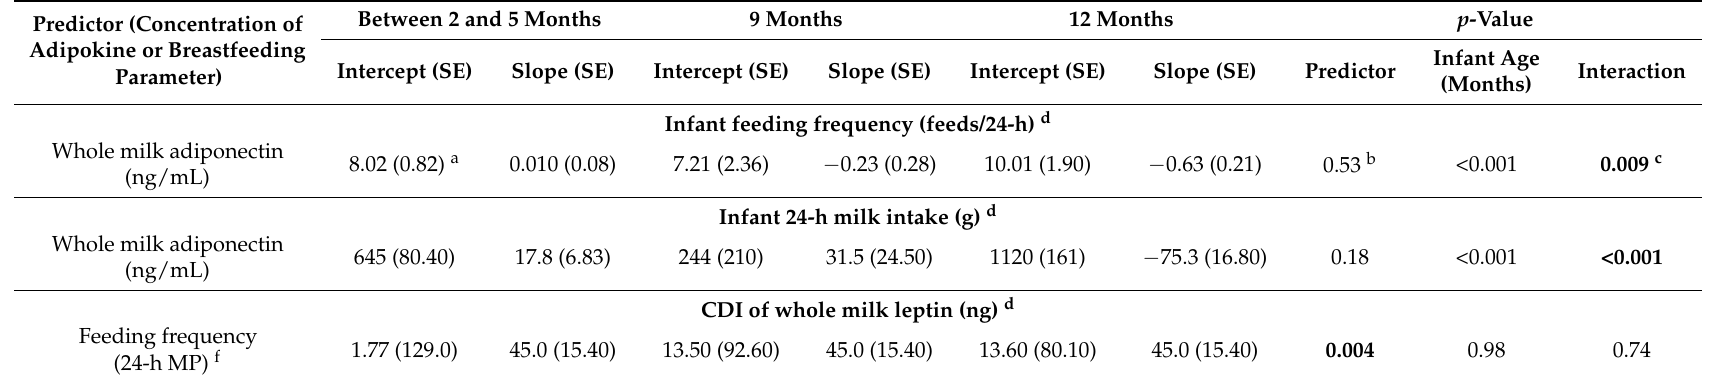
Table A4. Associations between human milk adipokines and breastfeeding parameters.